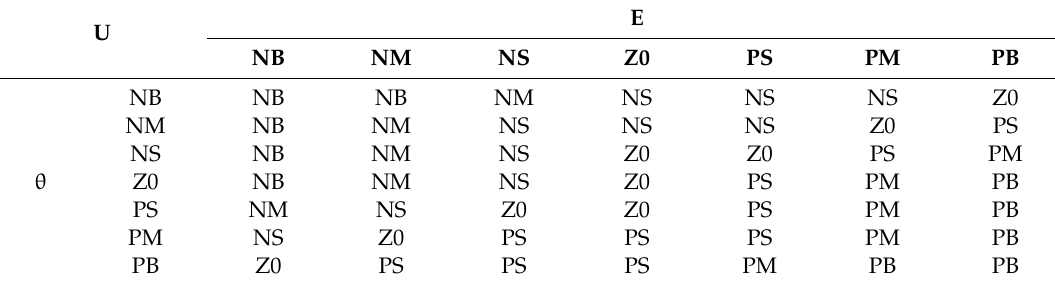
Table 1. The fuzzy control rules.